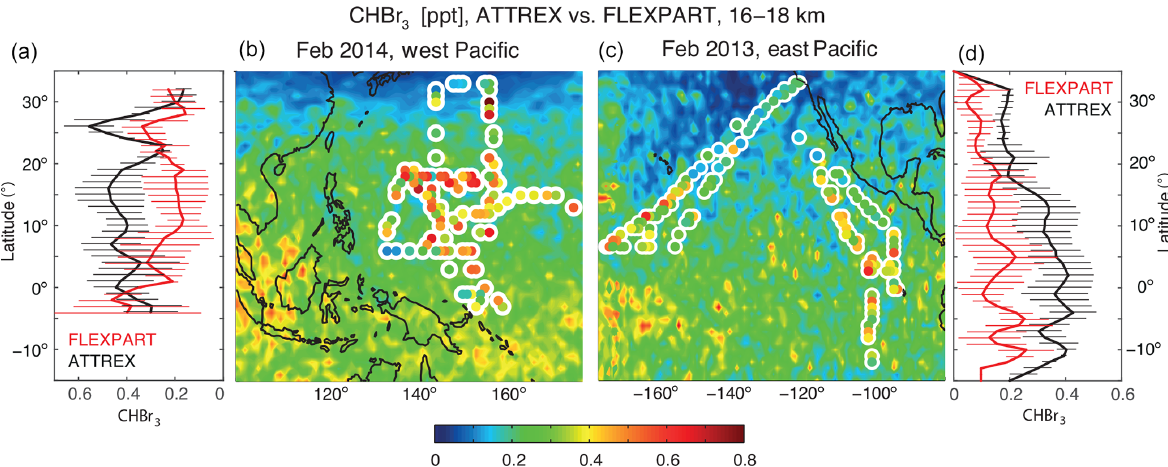
Figure 7. Modelled distribution of CHBr 3 in the uppermost TTL from FLEXPART (background colouring) in comparison with ATTREX aircraft campaign measurements (coloured symbols with white edges) is given in (b) and (c) . Zonal means of coincident model–measurement comparisons are given in (a) for FLEXPART and the ATTREX campaign in February–March 2014 in the west Pacific and in (d) for FLEX- PART and the ATTREX campaign in February–March 2013 in the east Pacific. Temporal and spatial variability of measurements and coincident model values is shown in form of the 1 σ standard deviations over all values in the respective zonal bin (horizontal